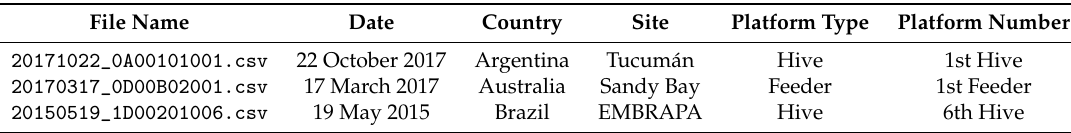
Table 2. Examples of file names and the interpretation of their